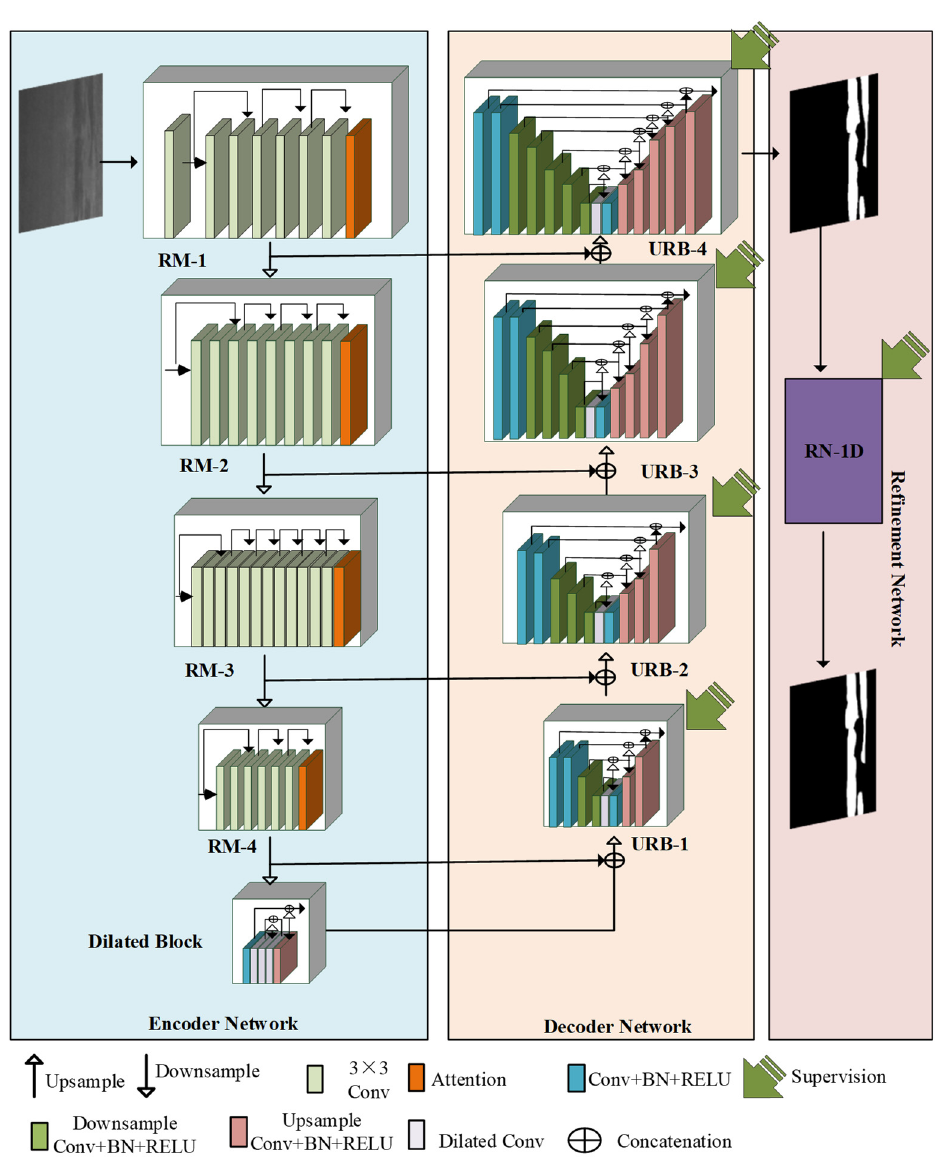
Figure 2. Architecture of our proposed nested U-shaped residual codec network, named NURCNet.